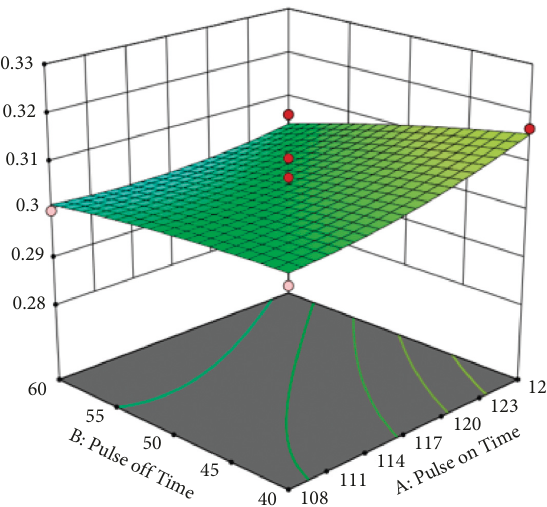
Figure 12: Joint performance on kerf width by T on and T off .